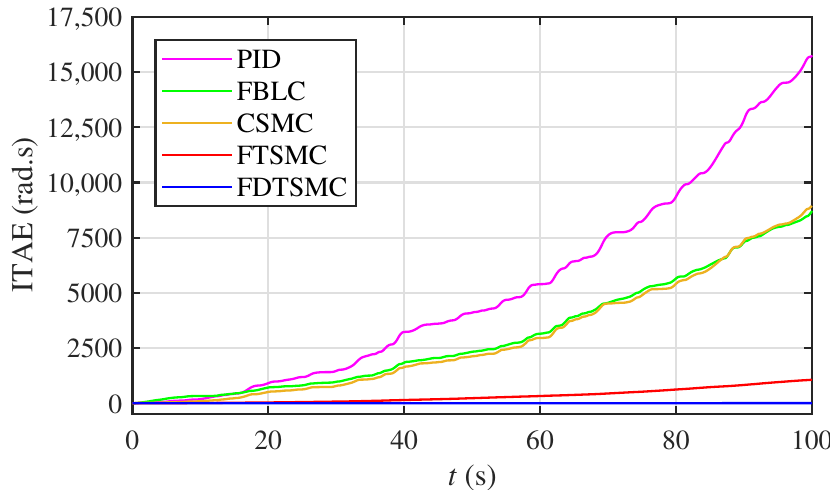
Figure 18. Integral of time absolute